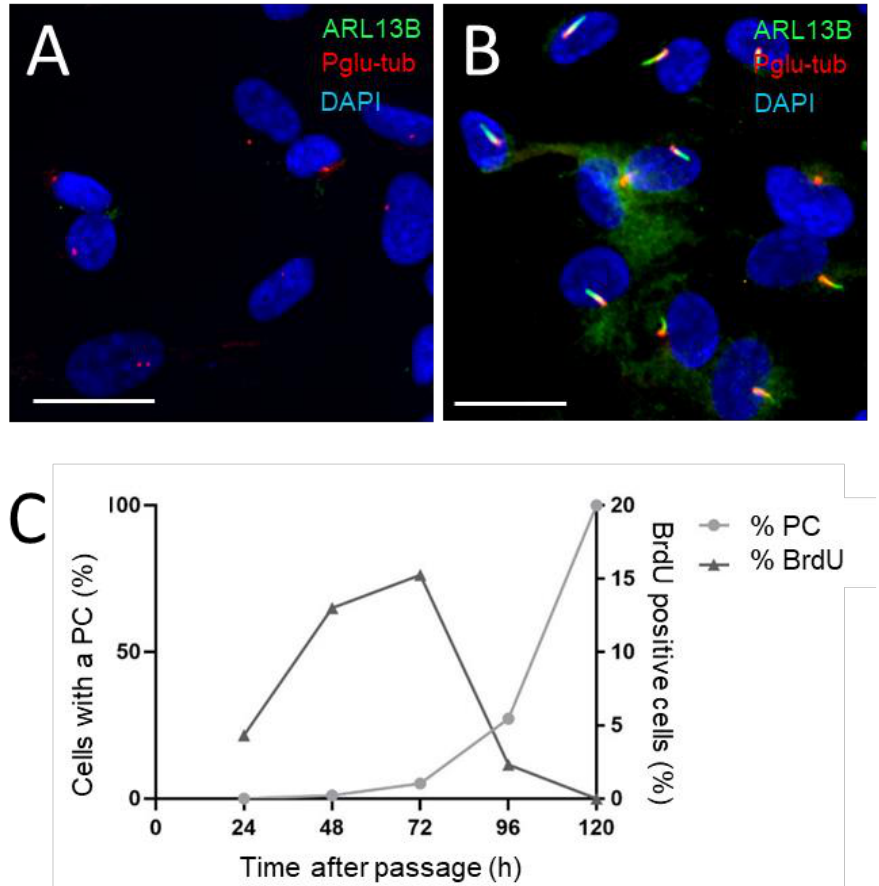
Figure 11. Expression of the primary cilia in quiescent HIEC cells. ( A , B ): Representative indirect immunofluorescence for the detection of ARL13b with 17711-1-AP (green staining) and polyglutamylated tubulin (Pglu-tub; red) in subconfluent ( A ) and postconfluent ( B ) HIEC cells. ( C ). Representative experiment showing primary cilium (PC) and BrdU counts in percentage of total DAPI stained cells in synchronized cells at 24 h intervals after passage. PC and BrdU counts were performed in separate dishes. The experiment was repeated three times. Bars are equal to 10µm.